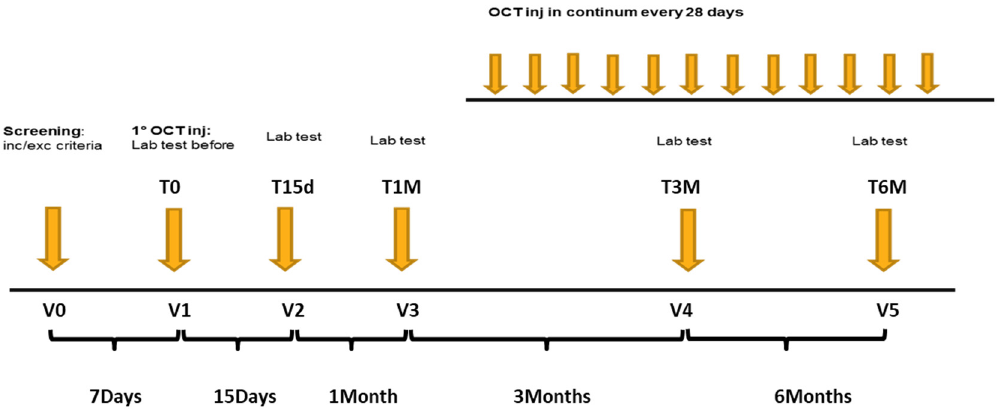
Figure 1. Flow Chart of the study design.